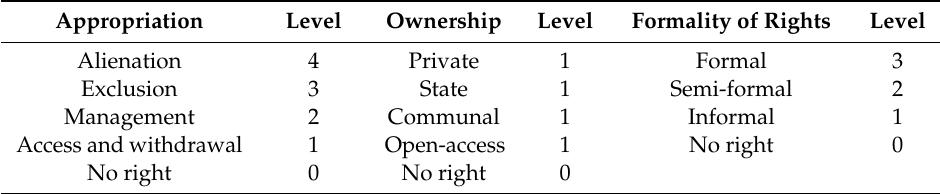
Table 4. The security level of each bundle of